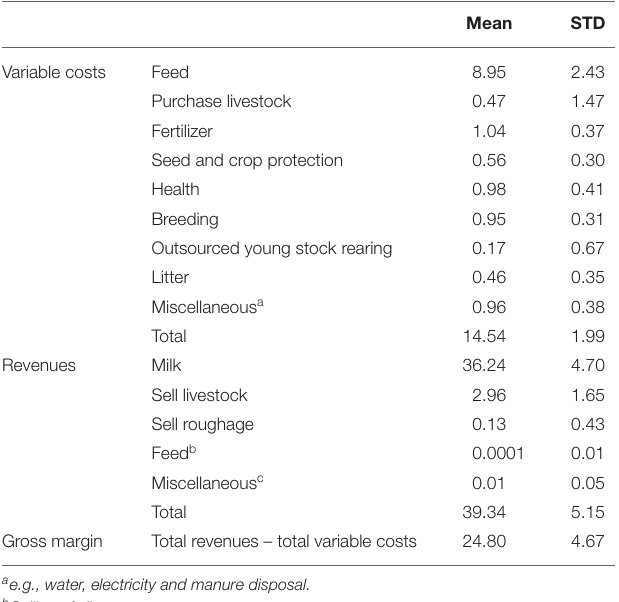
TABLE 2 | Descriptive statistics on variable costs, revenues and gross margin (in e /100kg milk) over herds and years ( n = 855 herds).